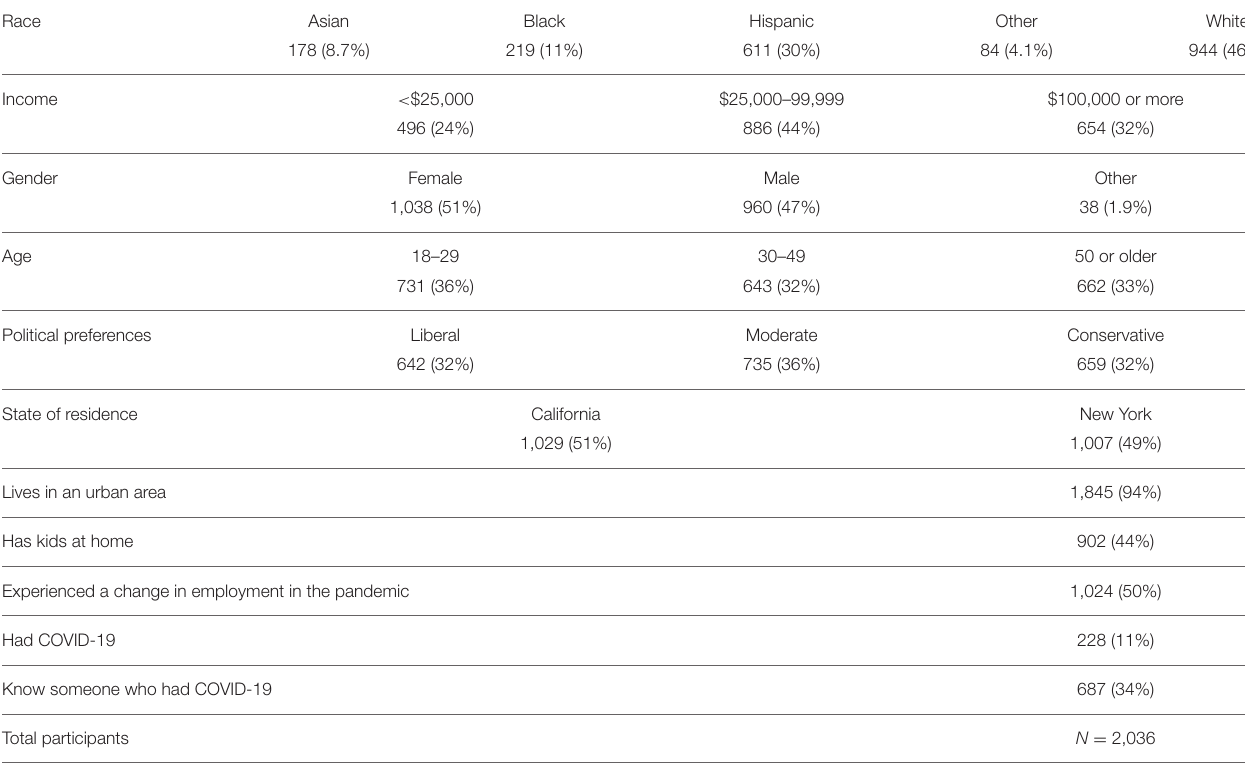
TABLE 1 | Descriptive statistics of